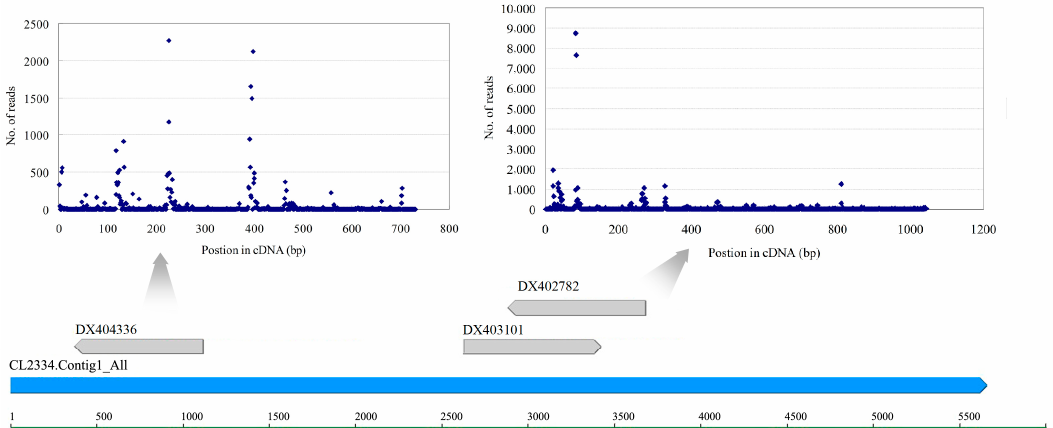
Figure 4. Distribution of small RNAs on three expressed retrotransposons.